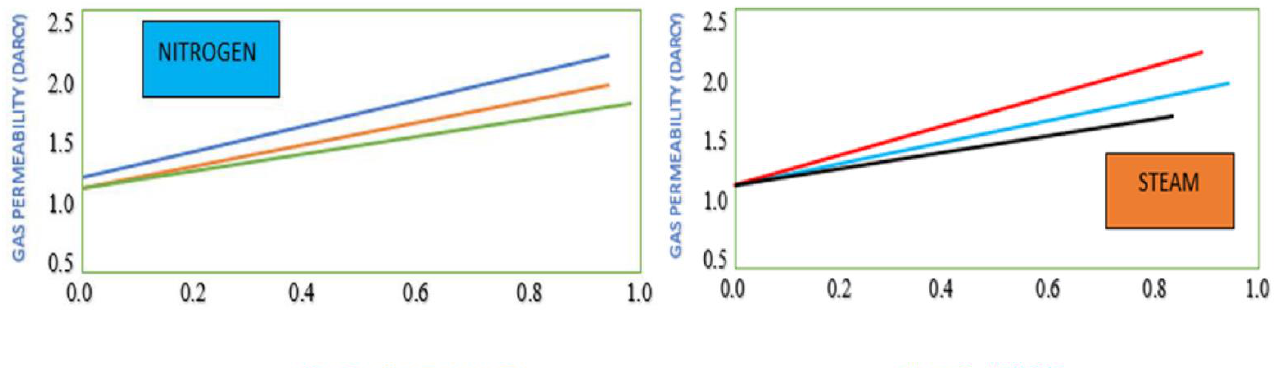
Figure 7. Comparison of the nitrogen and steam gas distribution effects at different temperatures.